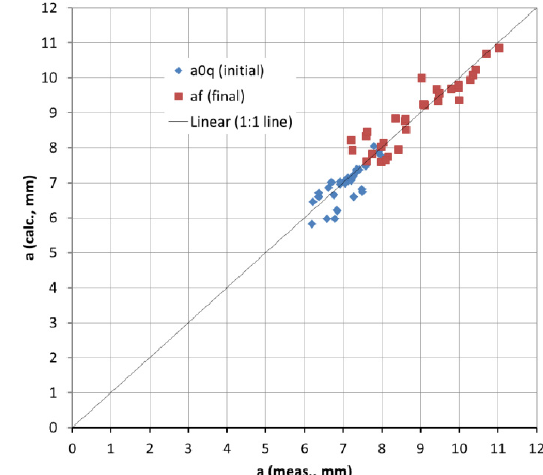
Figure 4: Comparison of calculated crack size with measured size.